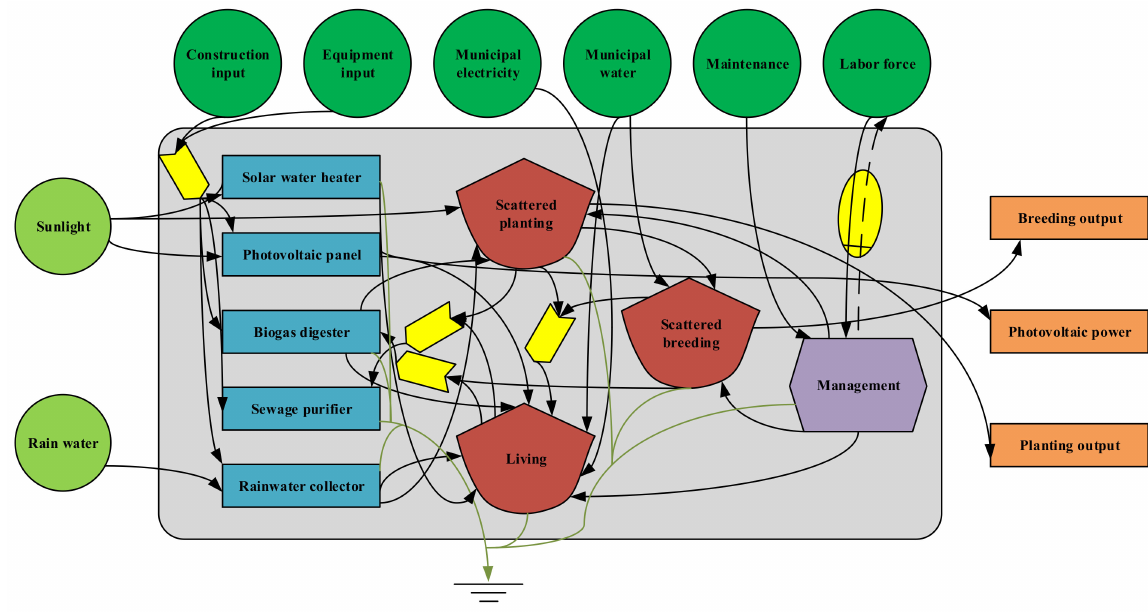
Figure 3. Energetic flow diagram of the courtyard